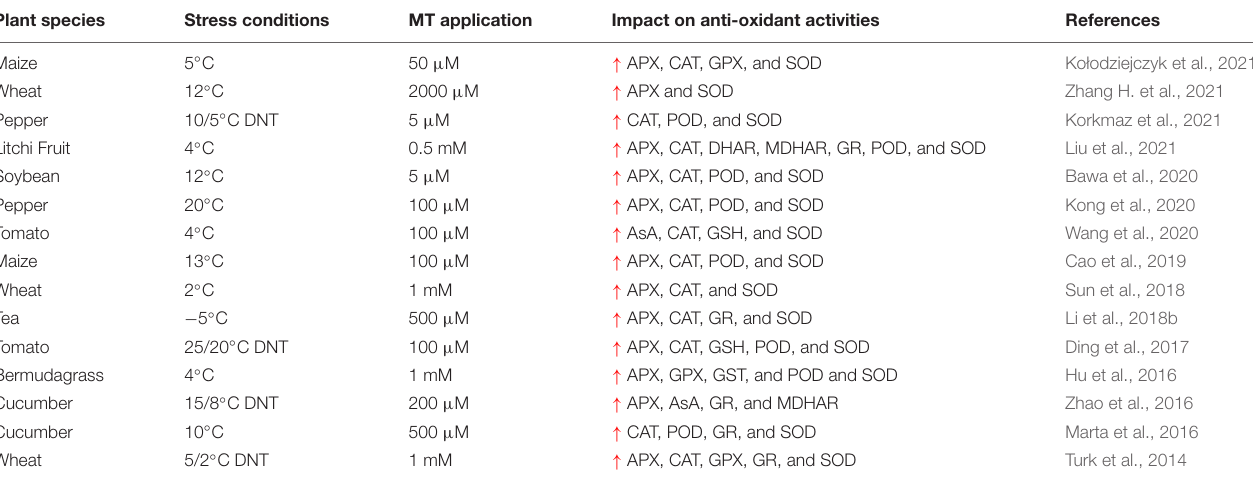
TABLE 4 | Effect of melatonin application on enzymatic and non-enzymatic activities under cold